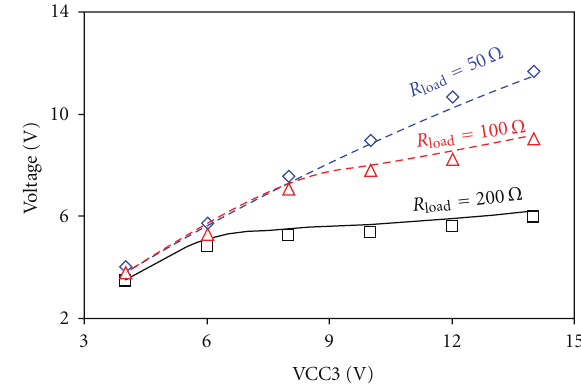
Figure 11: Measured (symbol) versus simulated (curve) amplitude of impulses generated with VCC1 = 3.3 V, VCC2 = 6.5V, and VCC3 = 4–14